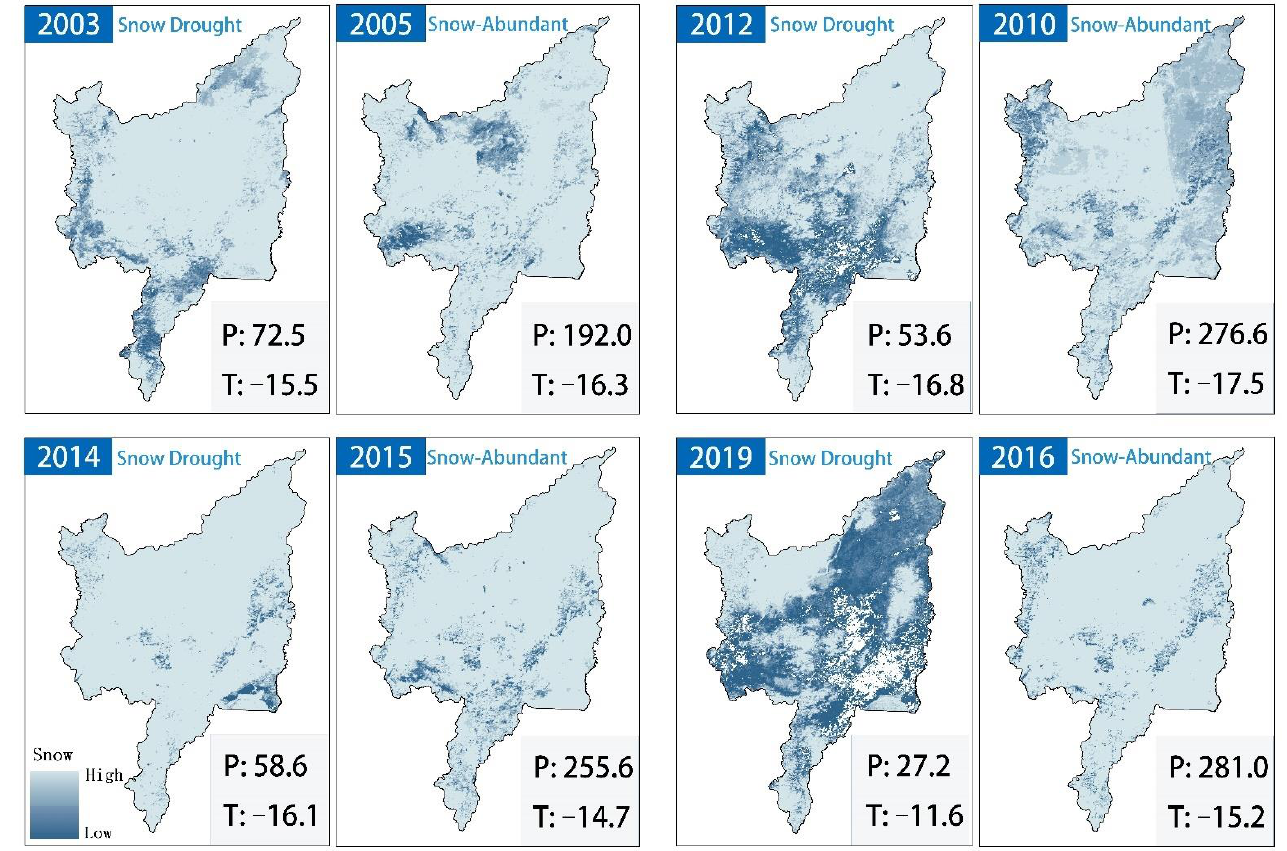
Figure 4. The spatial distribution of snowfall in the Sanjiang Plain. Each picture is the average snowfall cover from last year’s December to this year’s February. P: snow accumulation (mm); T: average temperature (°C).